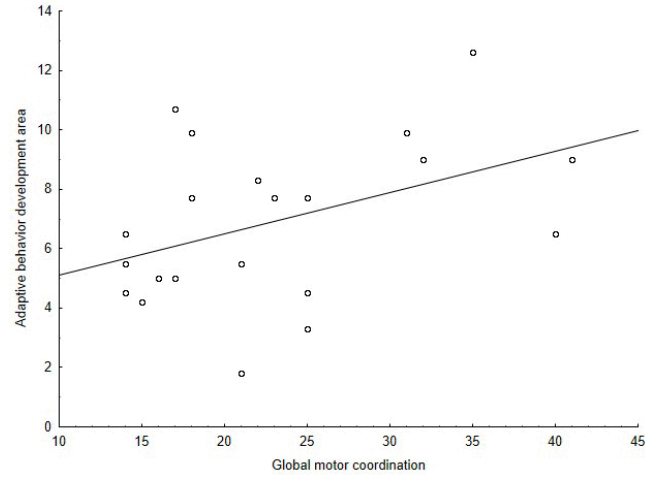
Figure 1. Correlation between global development of the DP-3 and global motor coordination of the M-ABC.